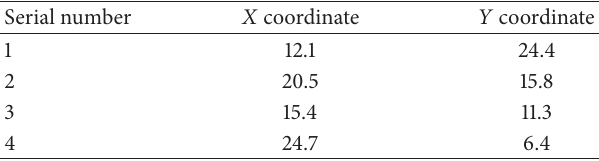
Table 5: The coordinates of the four alternative hubs.